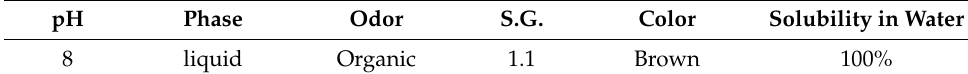
Table 3. Properties of the air-entraining agent in the Stable Air®system [34].